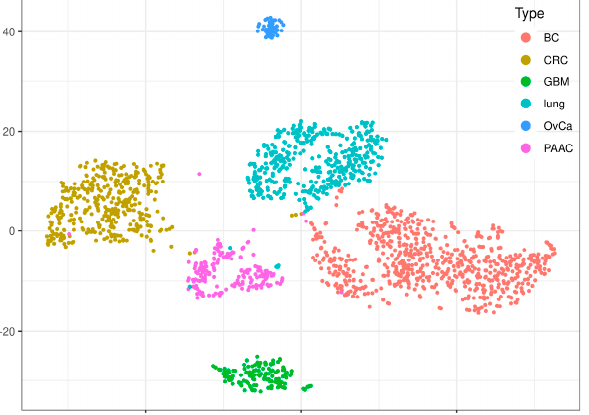
Figure 3. T-distributed stochastic neighbor embedding (tSNE) of the GB-averaged beta values of all cancer entities ( n = 7.403, measured from all cancer types).